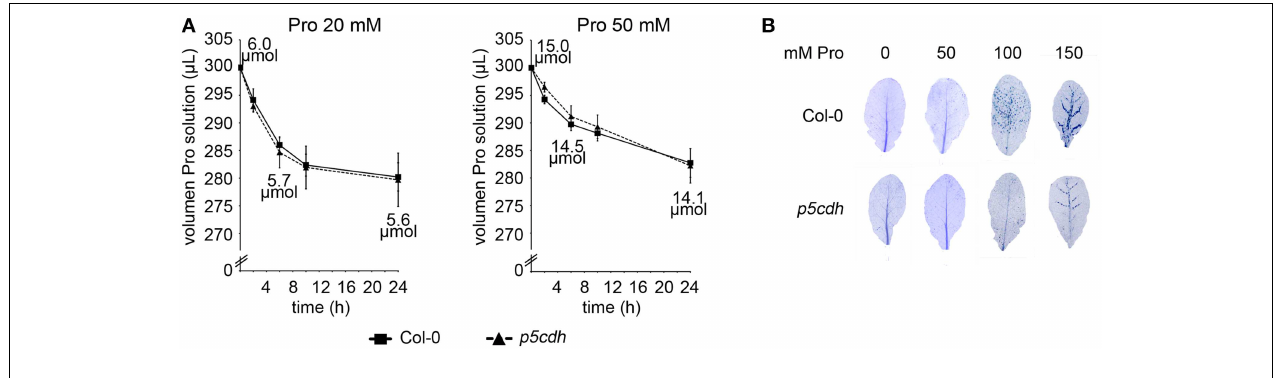
FIGURE 2 | Uptake and toxicity of Pro solutions in Col-0 and p5cdh detached leaves. (A) Detached leaves were incubated with Pro solutions for 24h (300 µ l, 20 or 50mM Pro). Pro uptake was evaluated by determining the volume of solution remaining in test